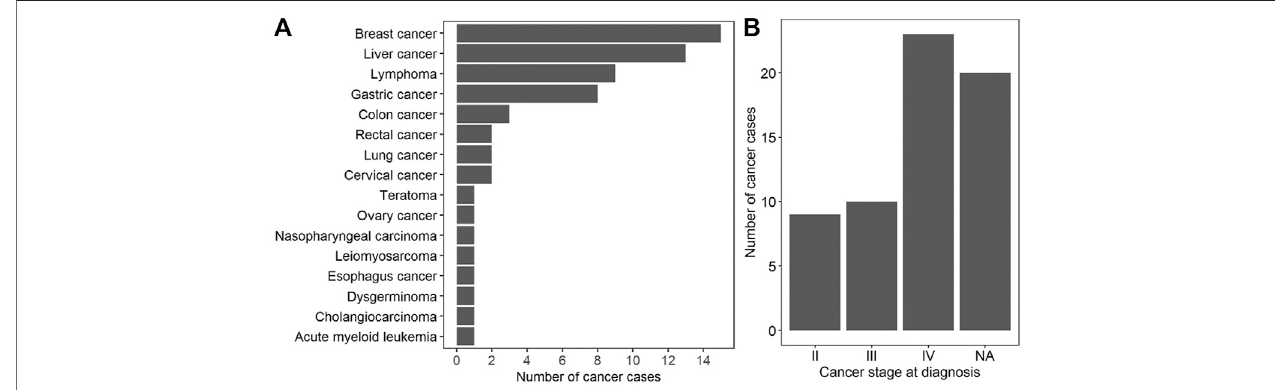
FIGURE1| Characterizationof62maternalcancercases. (A) Thenumberofcancercasesforeachcancertype. (B) Thedistributionofcancerstagesatdiagnosis. NA: not available.